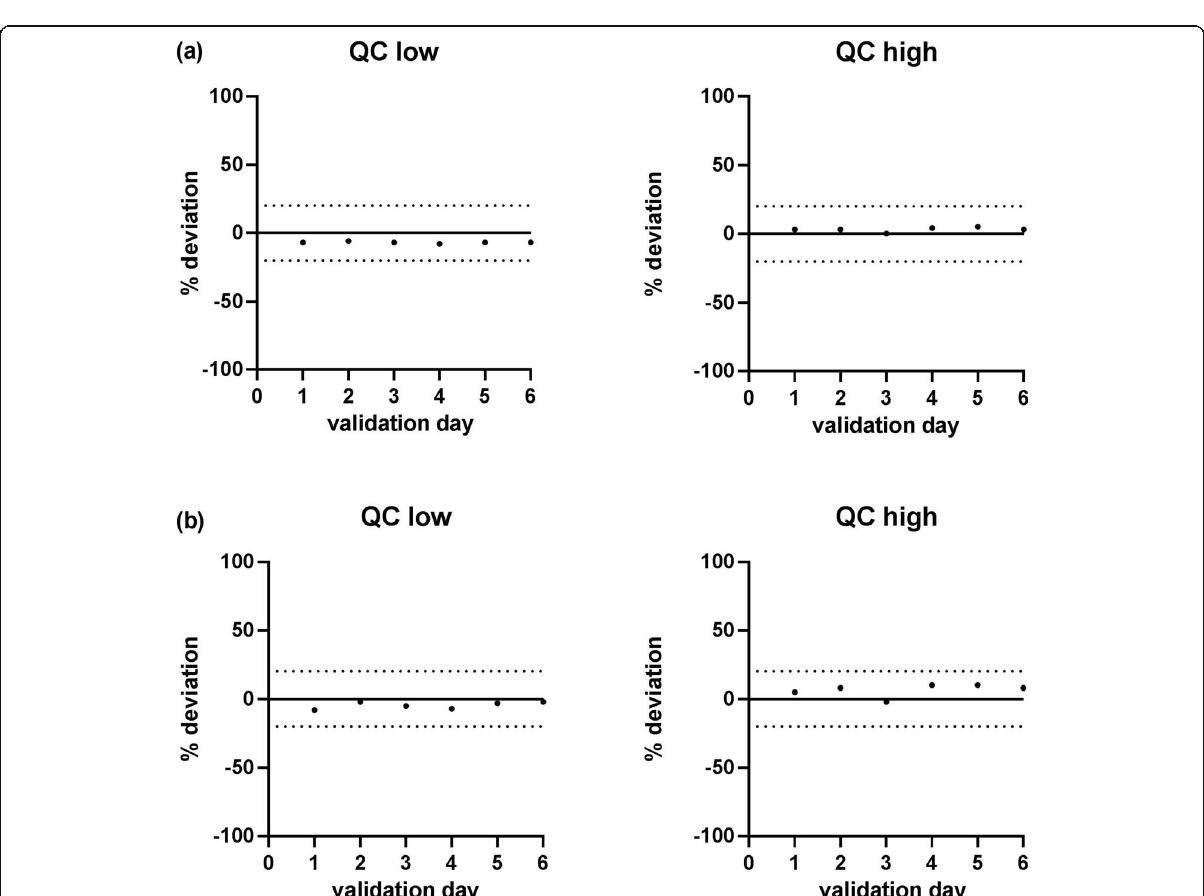
Fig. 3 Stability of calibration of QC low and QC high exemplified of ( a ) α -pinene and ( b ) bornyl acetate over six validation days calculated with the calibration equation of the first day. The dotted lines represent an error of ±